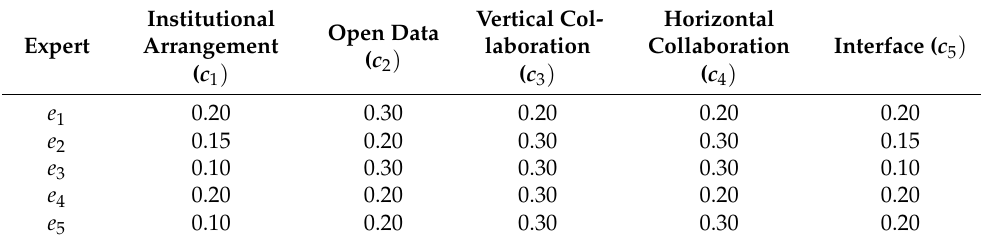
Table 2. Heavy weights (heavy weights are the weights that will be used to calculate the heavy ordered weighted average (HOWA) operator. Their difference with the weights in Table 1 is that w j = 1; in this sense, the weighting vector can be from heavy weights are not bounded to ∑ n j = 1 w j ≤ n ) provided by the experts. 1 ≤ ∑ n j = 1